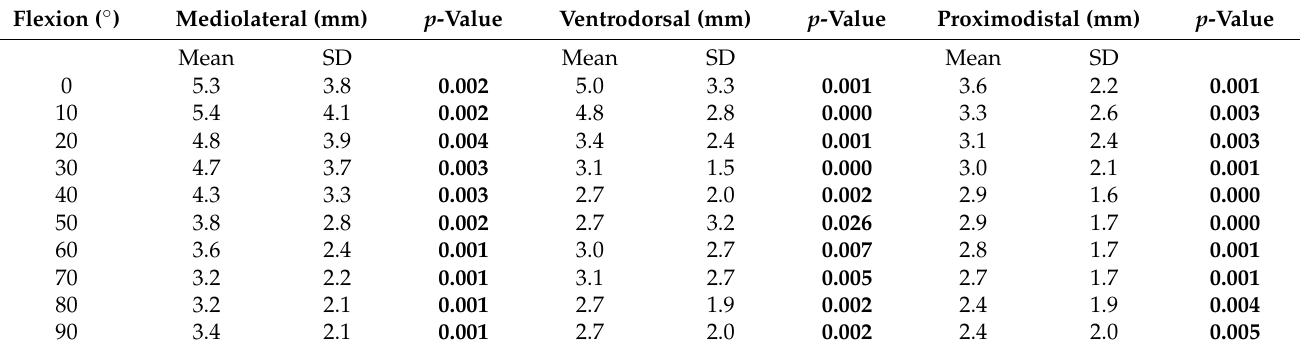
Table 4. Absolute shift in the lateral epicondyle after total knee arthroplasty (TKA). Absolute shifts in the lateral epicondyle (mediolaterally, ventrodorsally, and proximodistally) after TKA are shown in millimetres (means with standard deviations (SD)) every 10 ◦ of flexion. Bold characters mark significant differences ( p <